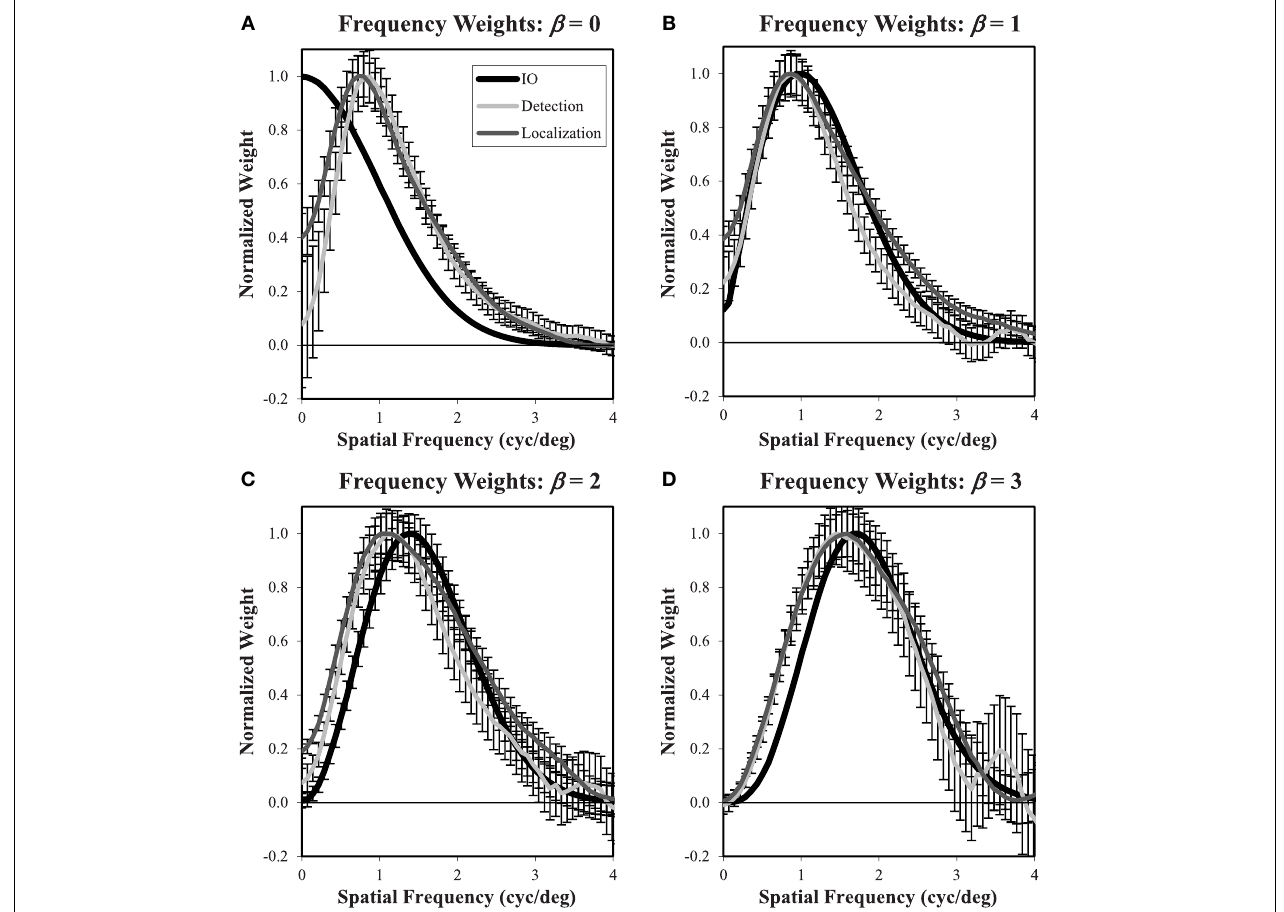
FIGURE 12 | Frequency weights derived from Classification images. Radial frequency profiles are shown for each of the four power-law textures (A–D) with normalization so that the maximum weight is one.